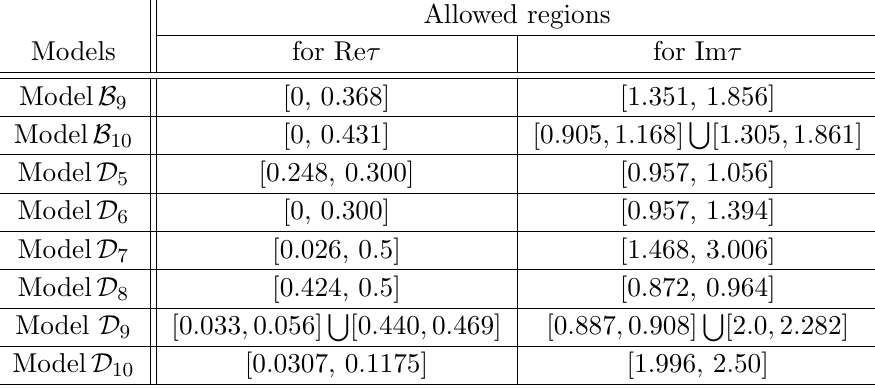
Table 15 . Phenomenologically allowed regions of (Re (cid:28); Im (cid:28) )